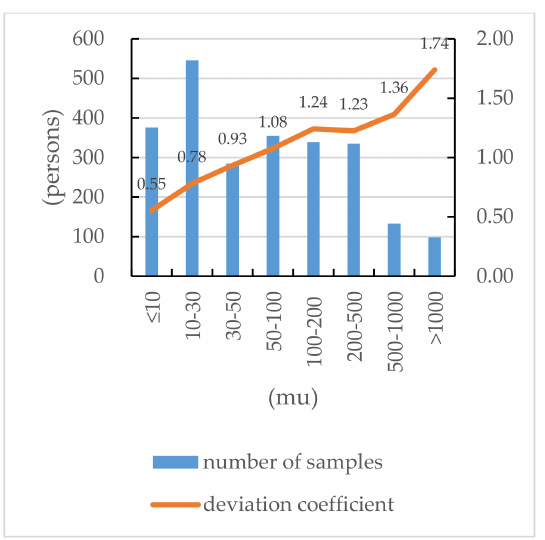
Figure 18. Deviation coefficient of agricultural machinery utilization rate grouped by cultivated land